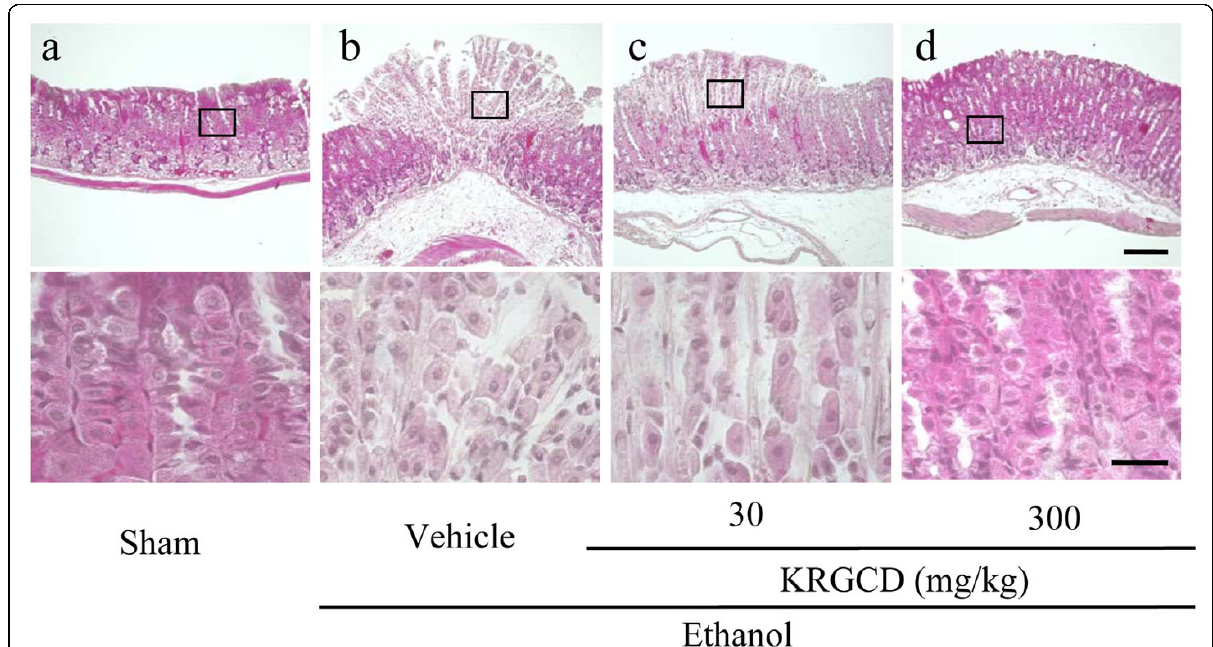
Figure 3 Effect of KRGCD on histological evaluation in an HCl/ethanol-induced ulcer model . Sections of hematoxylin and eosin (HE) staining (a-d). Section through gastric mucosa in the sham treated group (a). Microscopic appearance of lesions induced by HCl/ethanol in gastric mucosa pretreated with vehicle (b). Microscopic appearance of lesions pretreated with 30 mg/kg of KRGCD (c). Microscopic appearance of lesions pretreated with 300 mg/kg of KRGCD (d). Scale bar = 150 μ m (upper micrograph) and 30 μ m (lower micrograph).